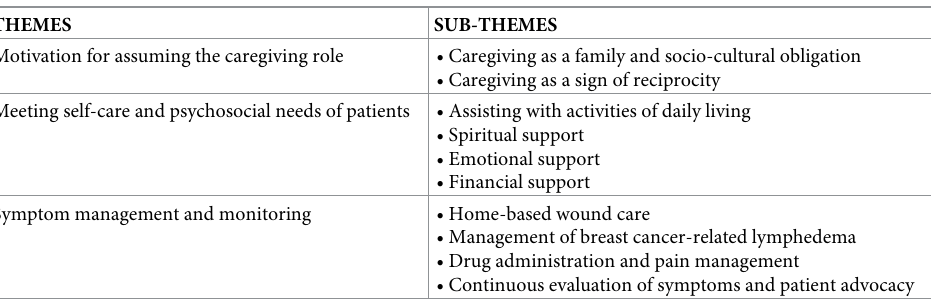
Table 1. Themes and sub-themes